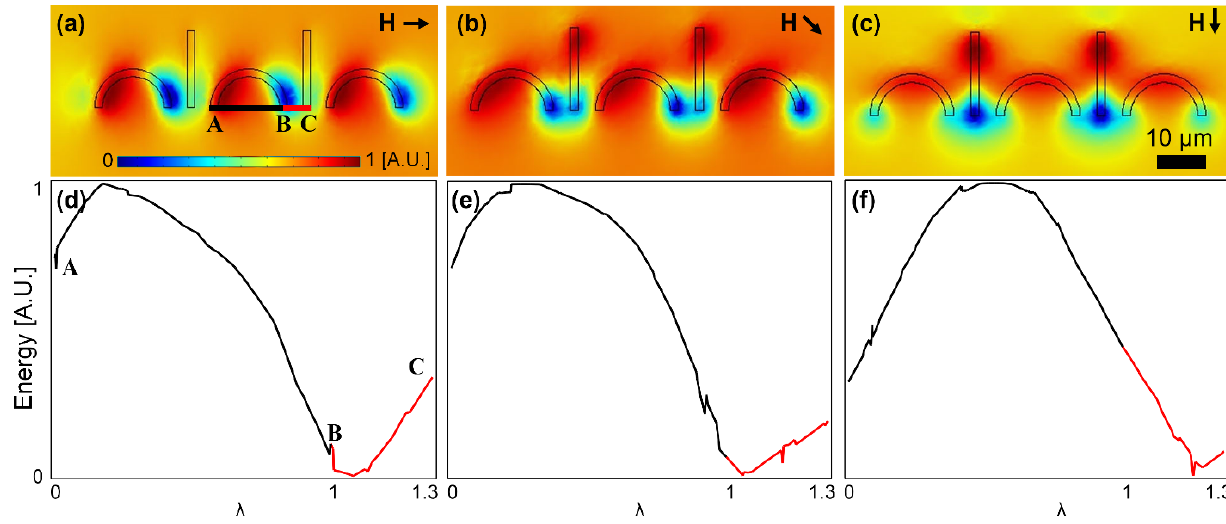
Figure 4. The particle transport from a C-shaped magnet to the next I bar is studied. ( a – c ) The potential energy distributions for three sequential magnetic field directions are illustrated. ( d – f ) The energies along the lines AB and BC (see ( a )) for the field directions of ( a – c ) are plotted in ( d – f ), respectively. The small black arrows stand for the magnetic field directions. The field is rotating clockwise, and the steps ( a – c ) are 45°. The energies are plotted at the center of a particle with a radius of 2.5 µm. The blue and red areas indicate the regions with low and high potential energies, respectively.